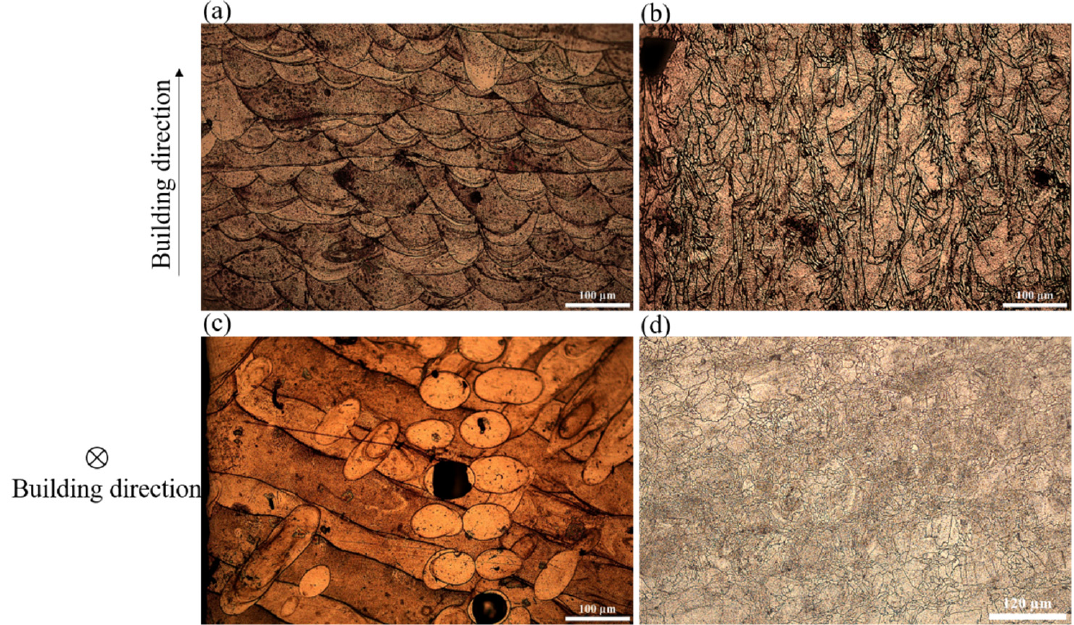
Figure 9. OM micrographs in the fully dense ( a ) as-built and ( b ) heat-treated CoCrMo alloys in the plane parallel to the building direction; ( c ) and ( d ) Those in the plane perpendicular to the building direction, respectively.